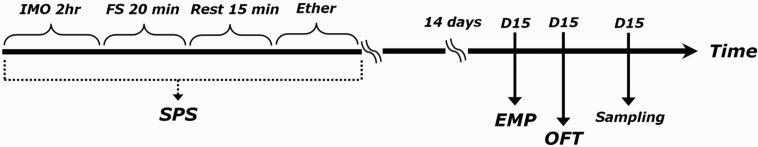
Experimental schedules for developing SPS-induced anxiety-like behaviors, and OLE treatment in the rats. Different groups of rats (n = 6 or 7 animals per group) were used for all experiments.